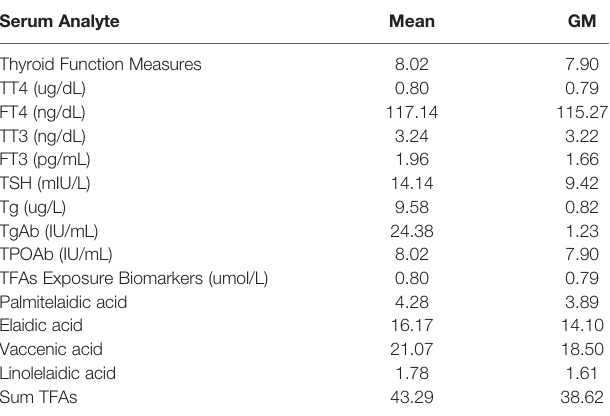
TABLE 2 | Distribution of serum TFAs concentrations and thyroid function